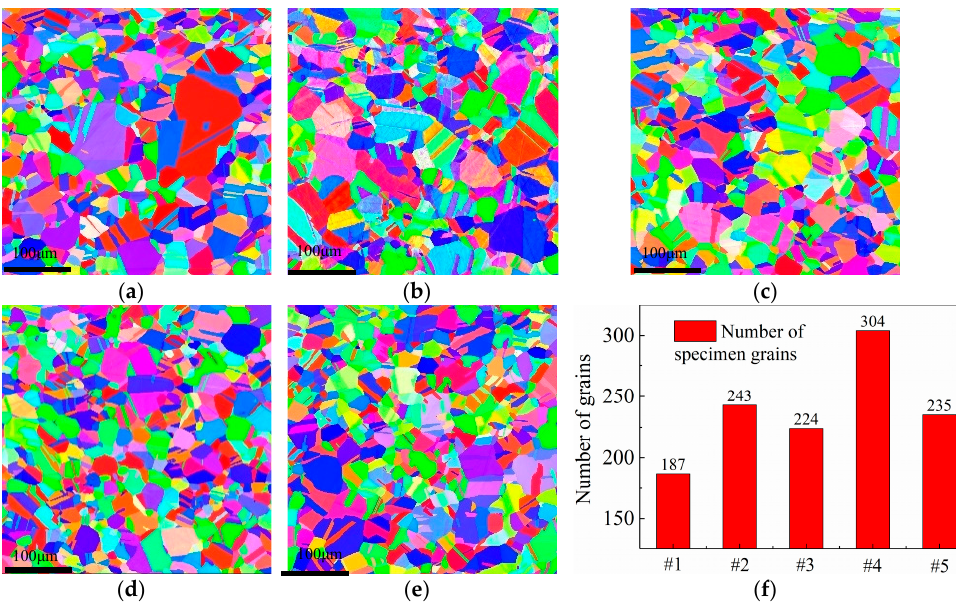
Figure 10. Grain morphology of specimens for different cryogenic parameters. ( a ) Specimen #1. ( b ) Specimen #2. ( c ) Specimen #3. ( d ) Specimen #4. ( e ) Specimen #5. ( f ) Number of grains for different cryogenic parameters.